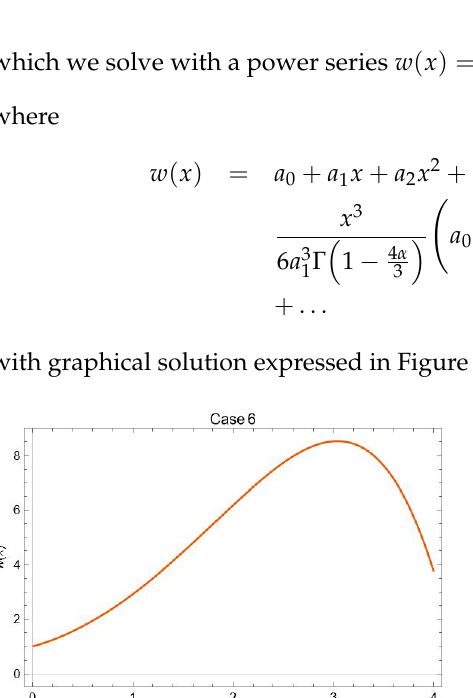
Figure 4. We let a 0 = 1, a 1 = 1, a 2 = 1, α = 1